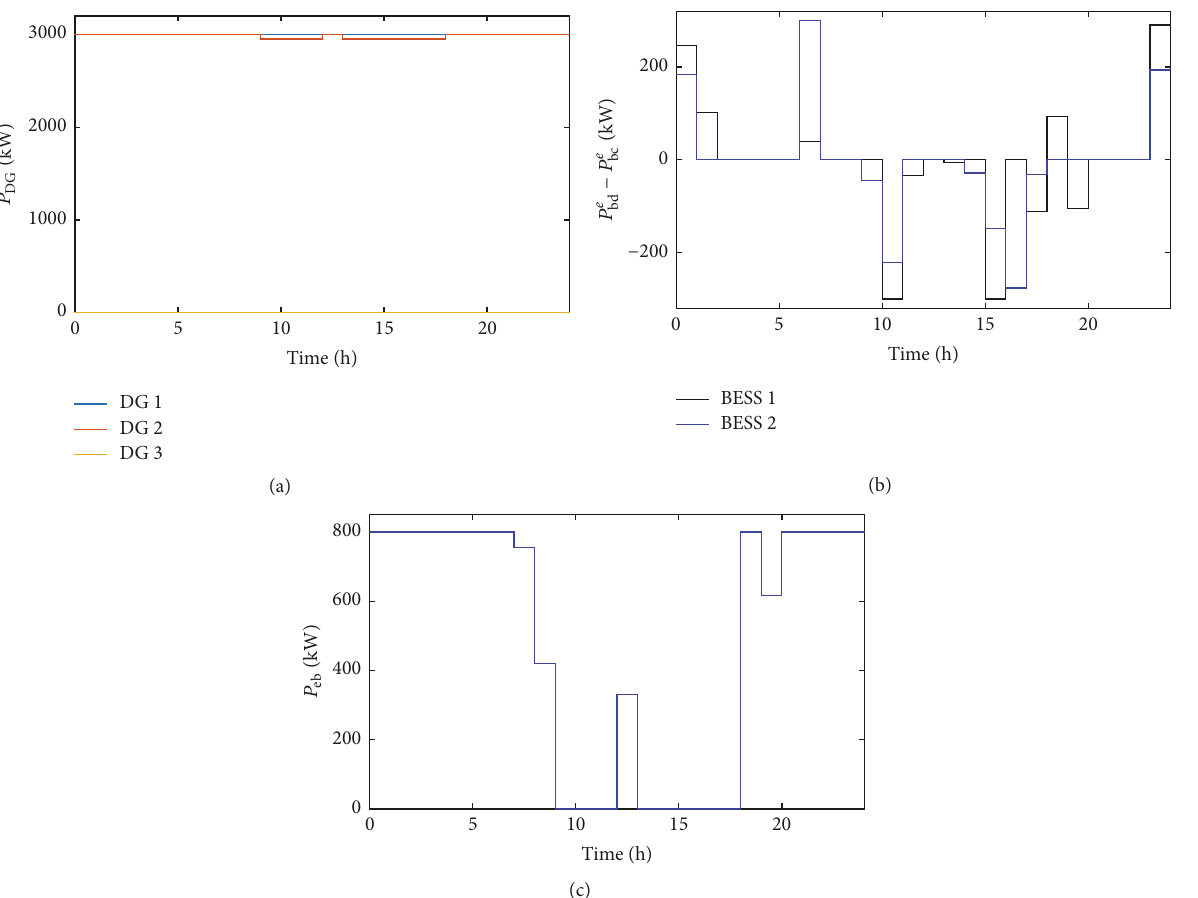
Figure 12: Optimal scheduling of modified IEEE 57-bus system: (a) dispatch values of DG 1, DG 2, and DG 3, (b) charge and discharge profiles of BESSs, and (c) 𝑃 eb .